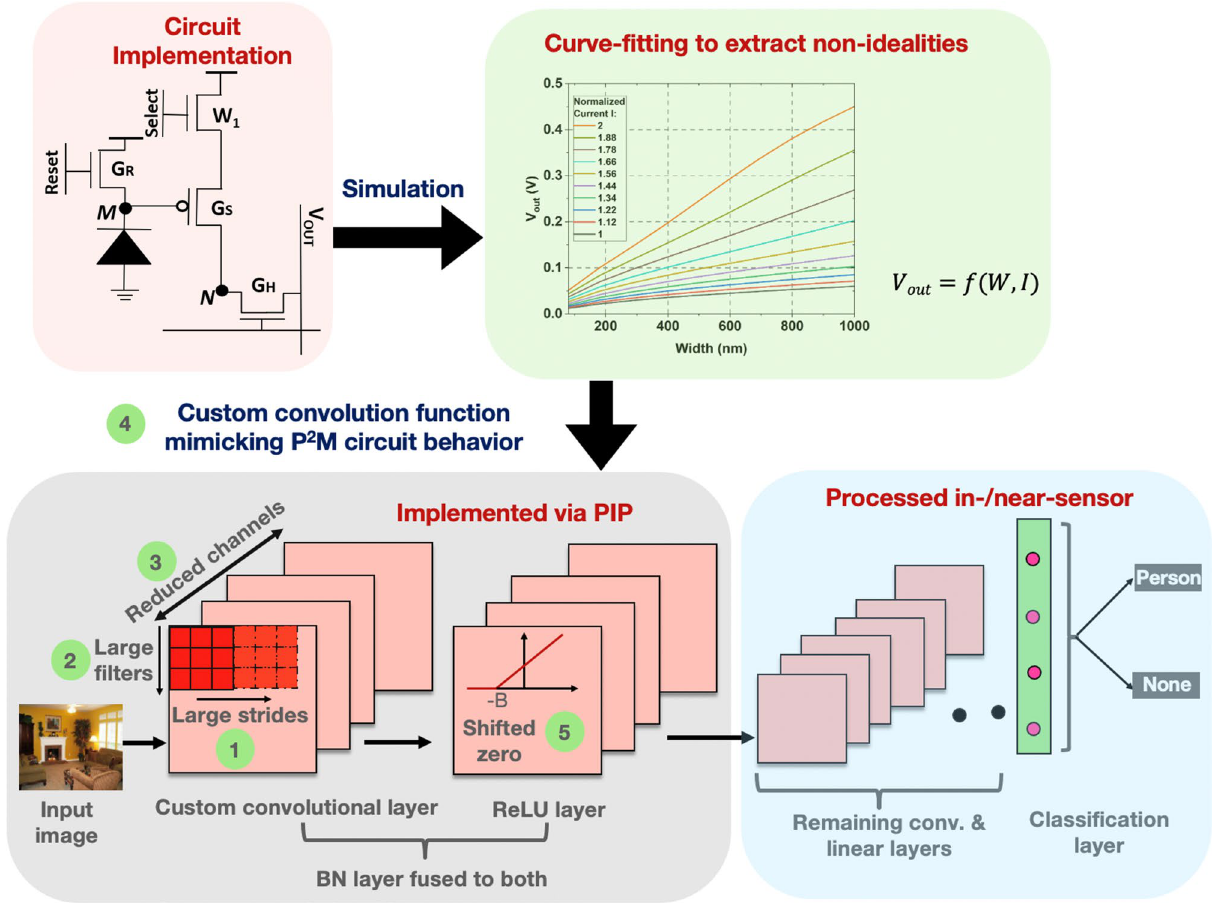
Figure 6. Algorithm-circuit co-design framework to enable our proposed P 2 M approach optimize both the performance and energy-efficiency of vision workloads. We propose the use of ① large strides, ② large kernel sizes, ③ reduced number of channels, ④ P 2 M custom convolution, and ⑤ shifted ReLU operation to incorporate the shift term of the batch normalization layer, for emulating accurate P 2 M circuit